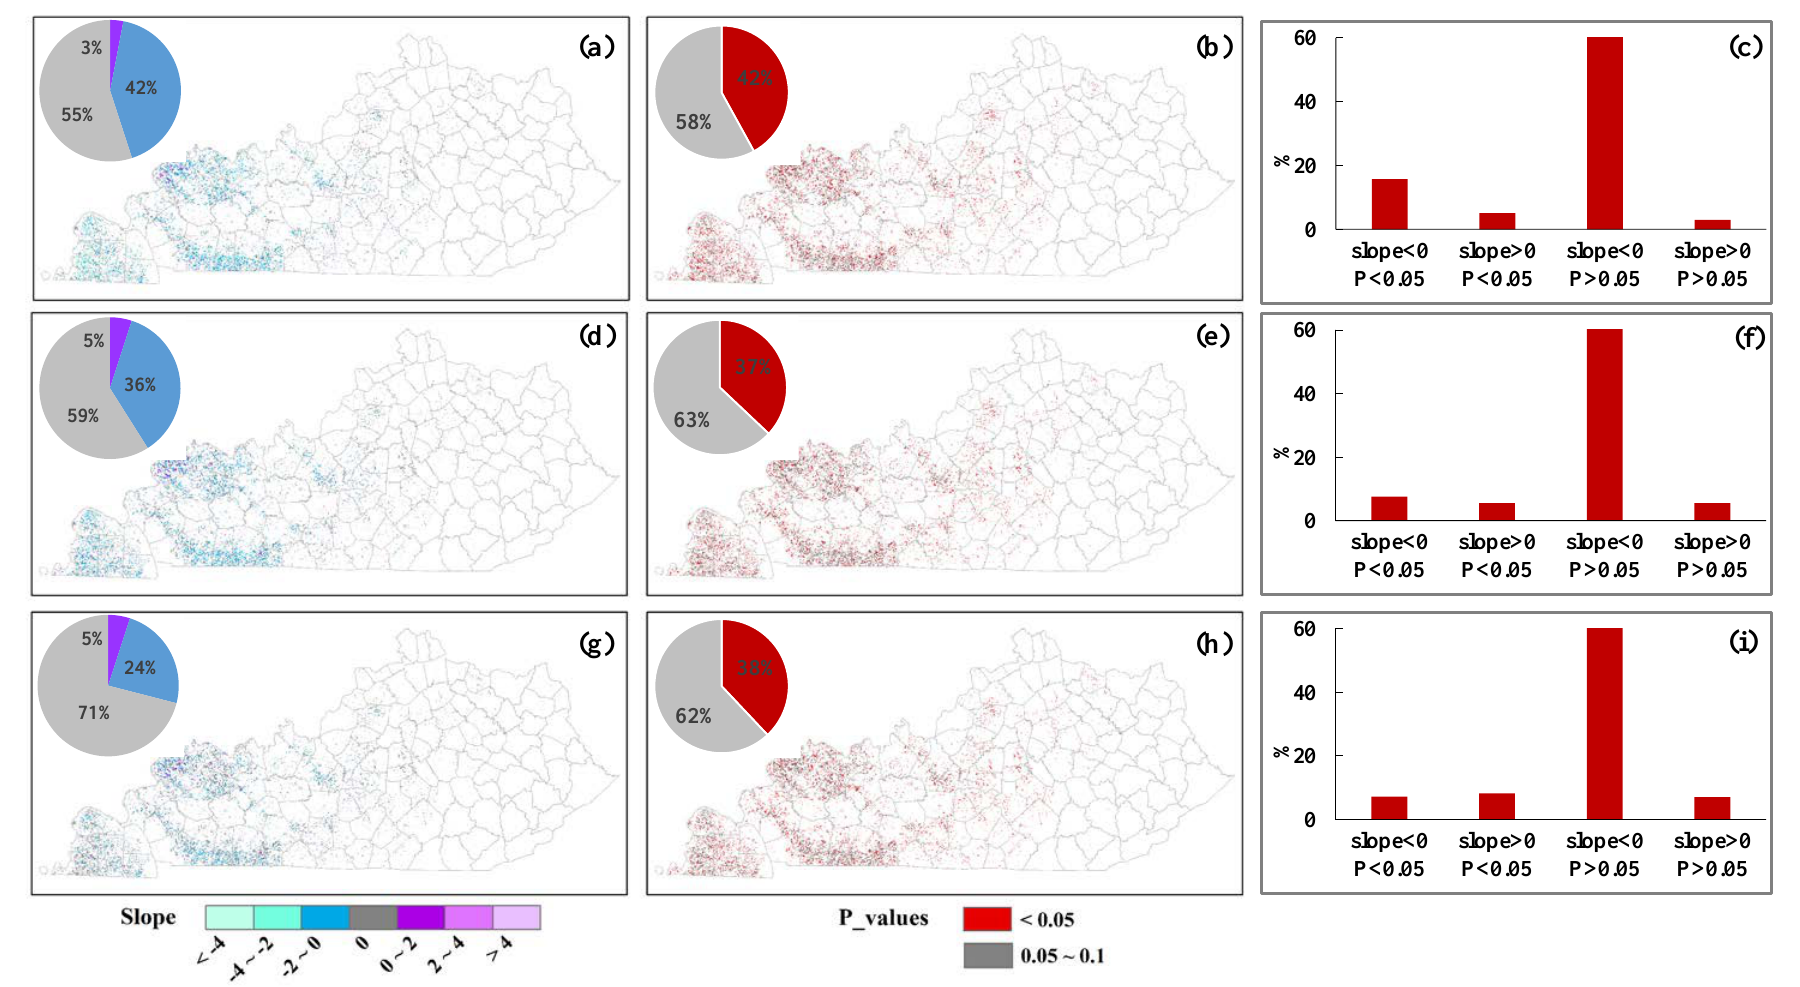
Figure 8. Slope, p values, and their percentages of planting dates ( a – c ) harvesting dates ( d – f ) and growing season length ( g – i ) of corn in Kentucky, 2000–2018 (Slope: change rate of crop phenological dates; p values: the confidence of trend analysis; we only included pixels that were identified as corn for more than 12 years in the Mann-Kendall statistical test).